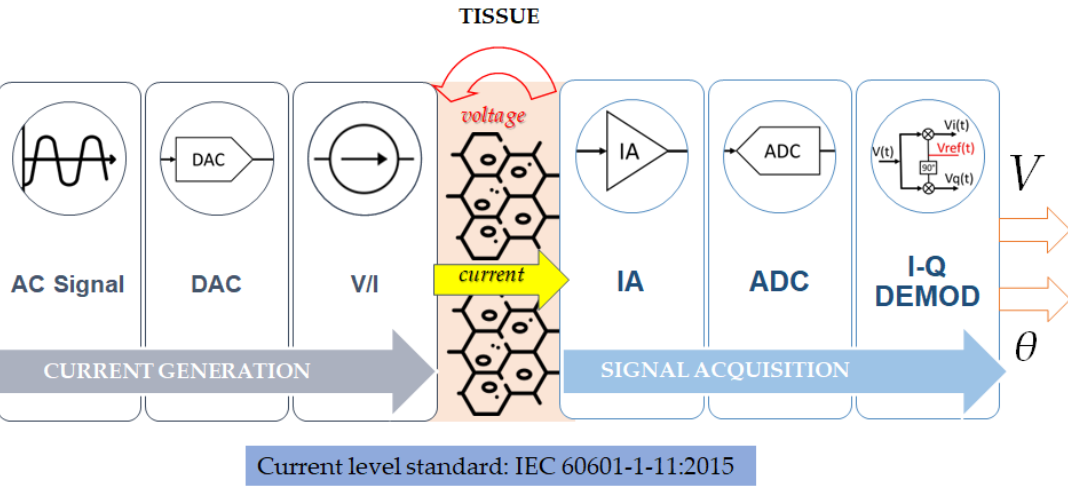
Figure 1. Block diagram of the hardware components of an EIT signal acquisition platform. The current generation block includes the digital signal generator, the digital to analog converter (DAC) and the voltage-to-current converter (V/I). The current is injected into the tissue, and the voltage